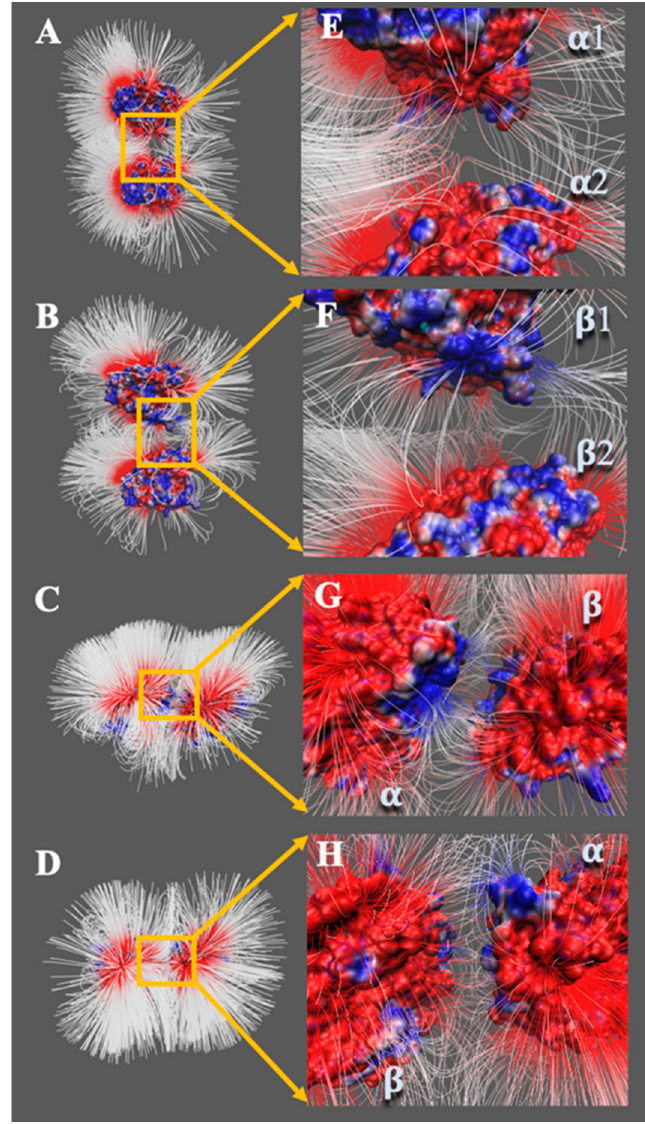
Figure 3. Electric field lines at the interfaces of interacting tubulins ( α / α , β / β , α / β , β / α ). The whole view of electric field lines of ( A ) α / α tubulin complex, ( B ) β / β tubulin complex, ( C ) α / β tubulin complex, and ( D ) β / α tubulin complex. ( E – H ) are the close-up views of ( A – D ), respectively.